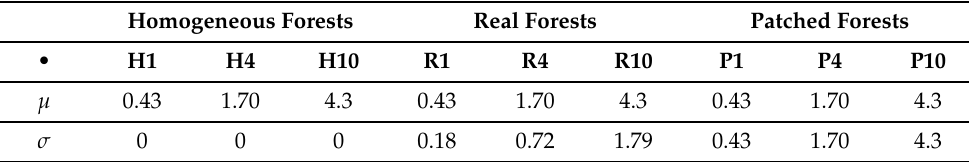
Table 2. Mean ( µ ) and standard deviation ( σ ) of LAI for respective forests. Homogeneous Forests Real Forests Patched Forests